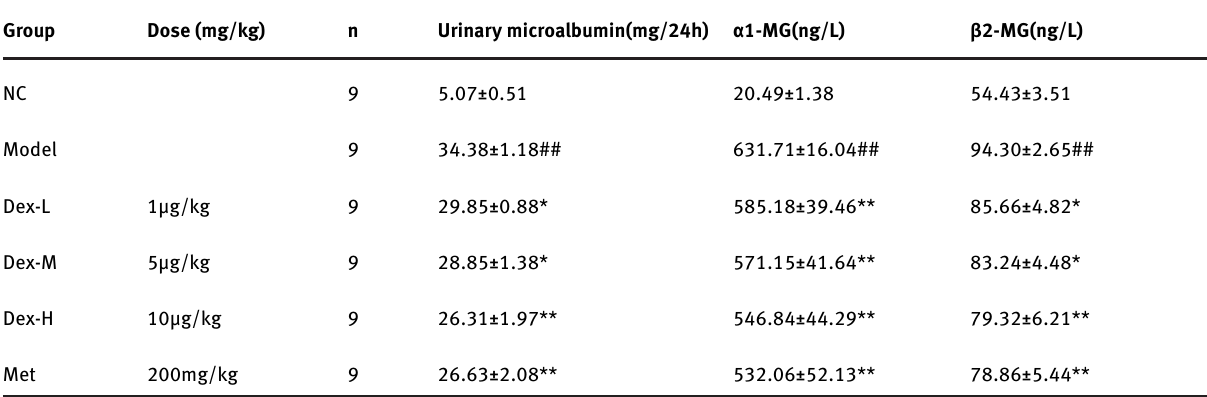
Table 1: Levels of markers of renal injury in rats of each group (Mean±SD, n=9)